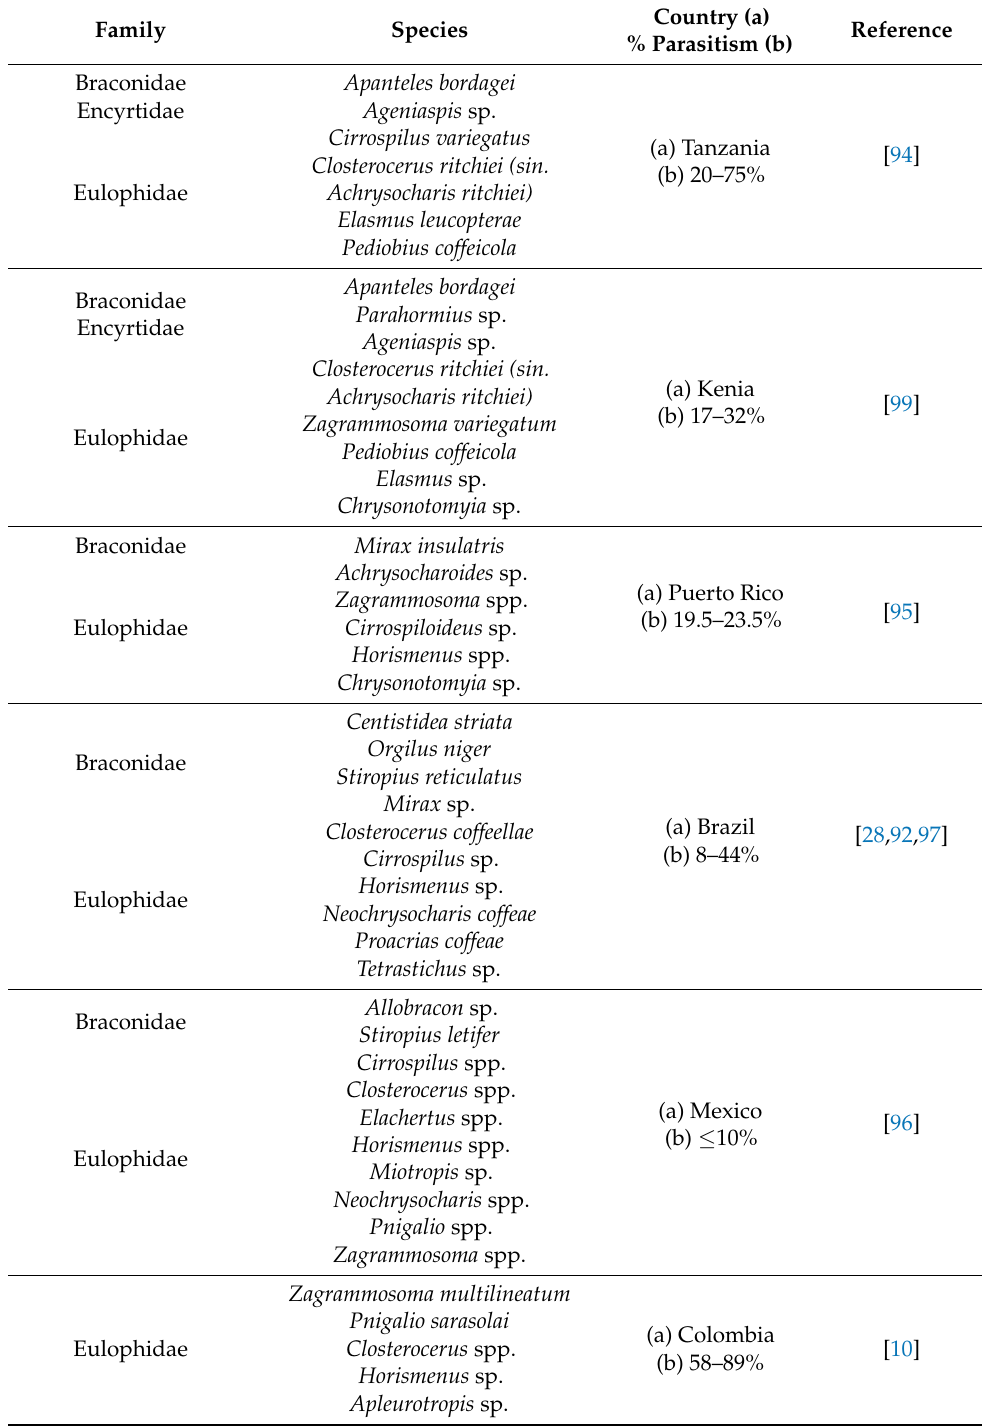
Table A1. Main hymenopteran species found in coffee growing areas parasitizing Leucoptera